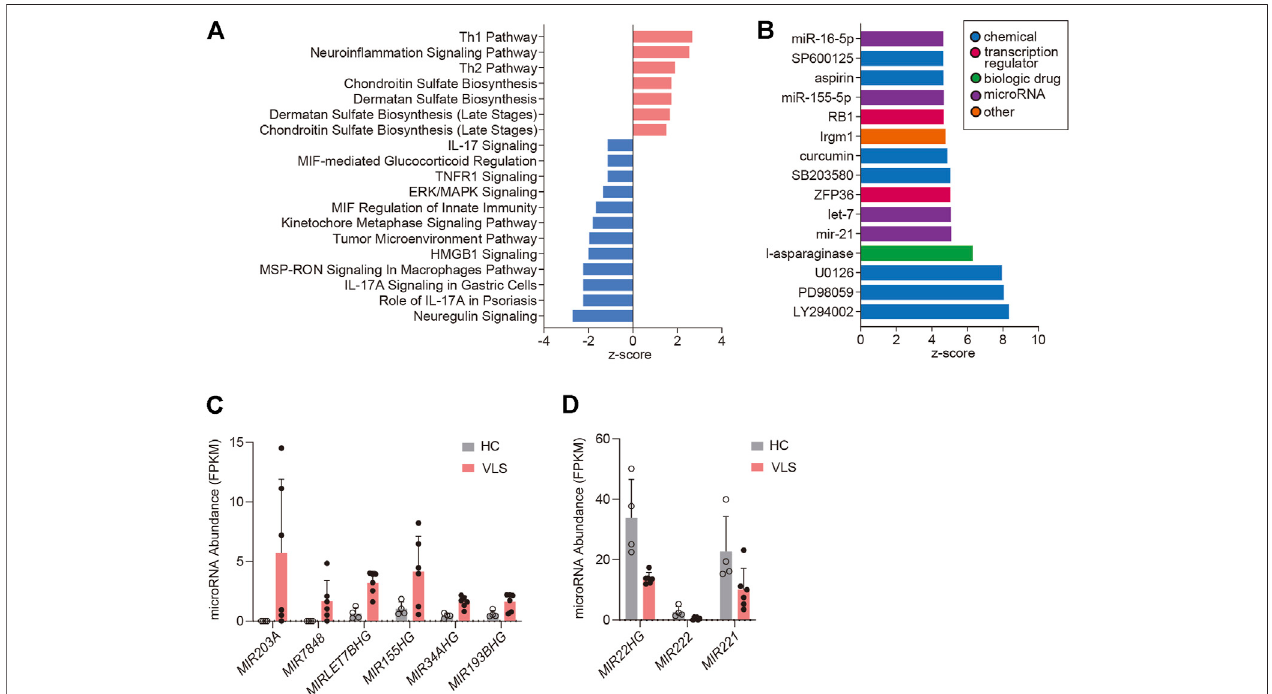
FIGURE3| Pathwayanalysisandupstreamanalysis. (A) EnrichmentofthetopclustersusingIPAGOalgorithmsforallsigni fi cantDEGs.Thethresholdofminimum signi fi cance was set to FDR < 0.05. The z-score predicts the direction of change for the function, and the threshold was set to an absolute value of z-score > 1. (B) Upstream Regulator Analysis. The top 15 activated upstream regulators ranked by z-scores are presented as a bar chart. (C,D) RNA-Seq data showing microRNA abundances in six VLS and four healthy samples. HC, Healthy Controls.